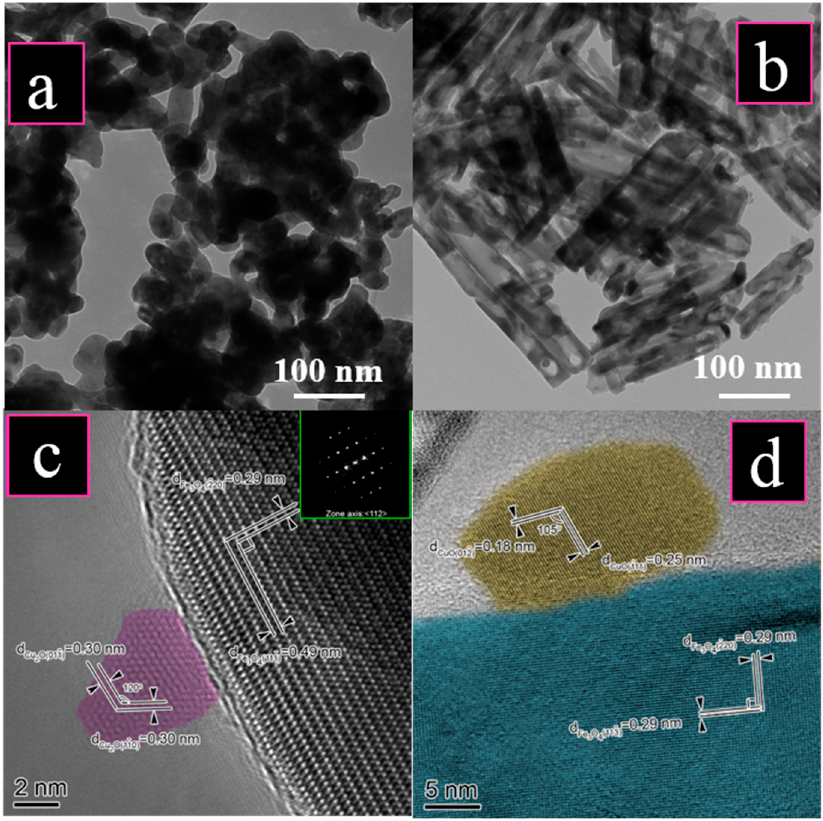
Figure 6. TEM and HR ‐ TEM images of reduced CuFe19 ‐ P ( a, c ) and CuFe19 ‐ R ( b, d ).